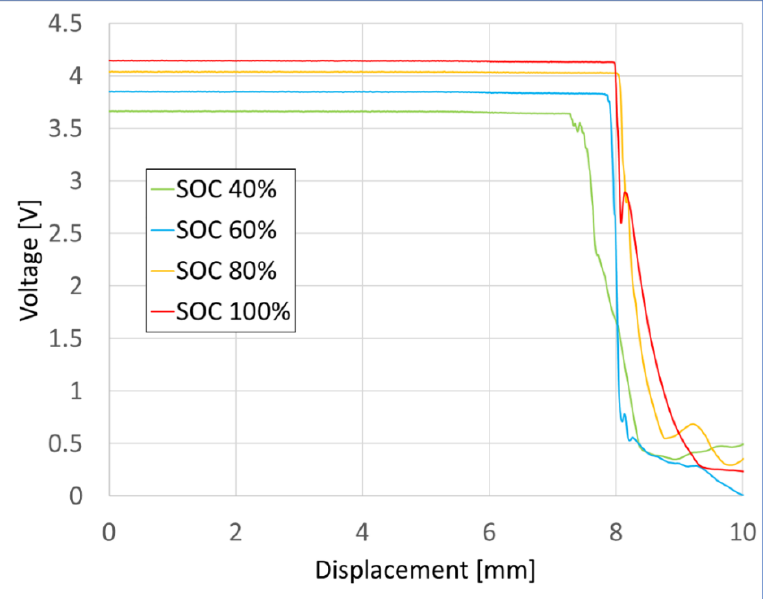
Figure 12. Voltage vs. displacement curves of experiments with different SoC at v = 10 mms −1 .